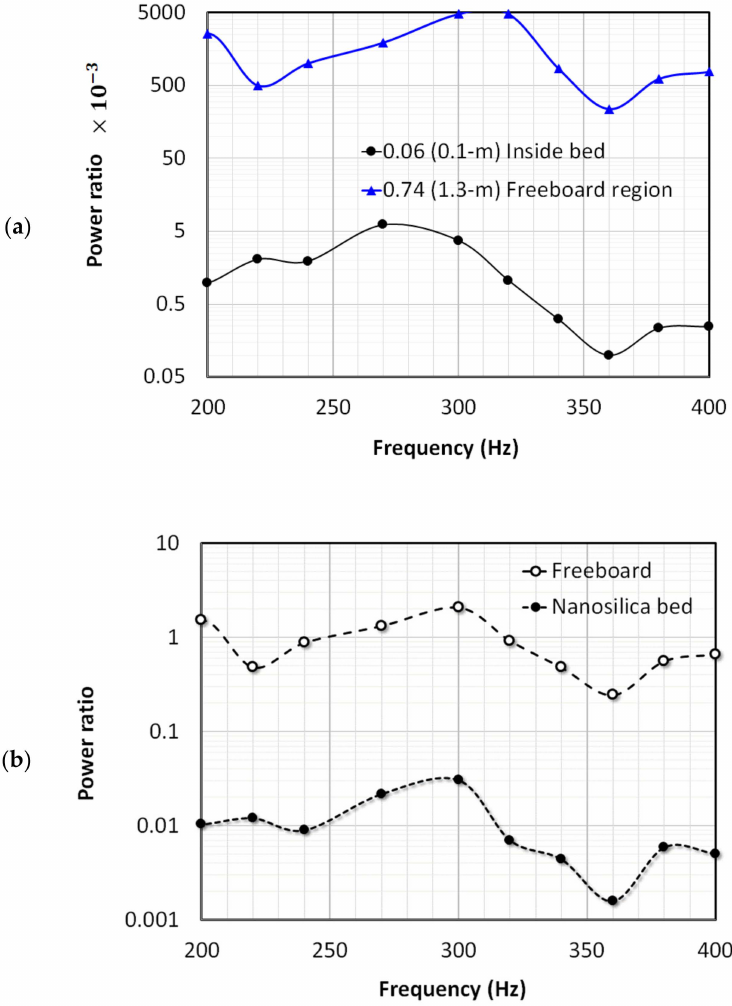
Figure 11. Effect of frequency on the acoustic attenuation ( a ) at a specific point inside the bed and in the freeboard region, and ( b ) the average effect for the entire bed and the freeboard region (the empty column values are used as